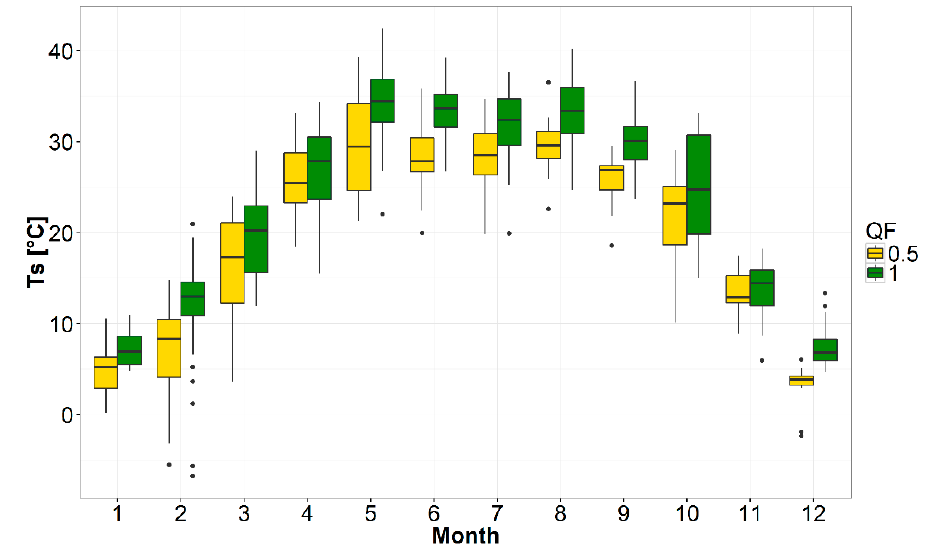
Figure A4. Values of estimated T s over the two eddy towers for months and QF.